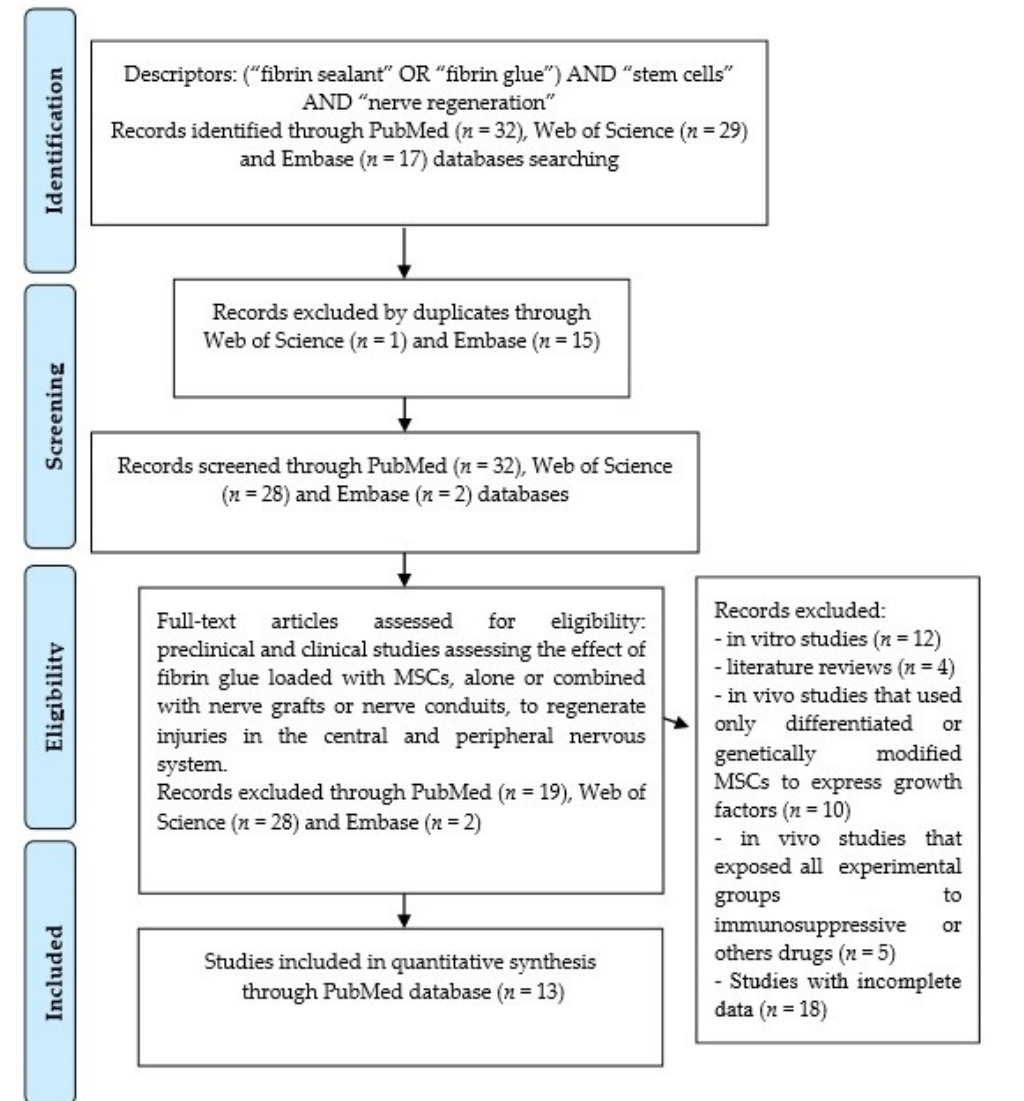
Figure 2. Prisma flow diagram resulted from an electronic bibliographic search for the potential of MSCs associated with fibrin glue in central and peripheral nervous system regeneration.